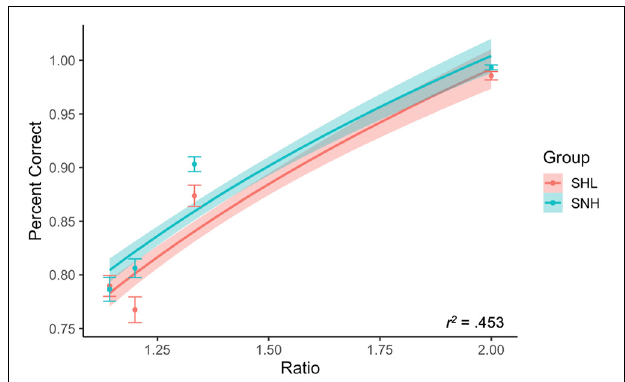
FIGURE 3 | Accuracy by trial ratio and group membership. As expected by Weber’s law, accuracy increased as a function of trial ratio. SNH were, on average, more accurate than SHL. There was no interaction between these two variables. Lines represents best-fitting logarithmic relationship between ratio and percent correct. Shading corresponds to 95%